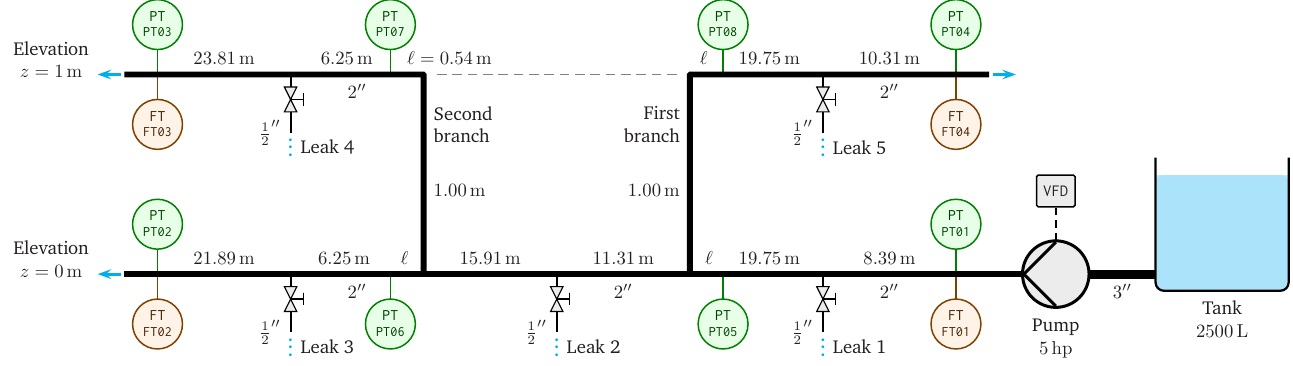
Figure 8. Pipeline system layout.